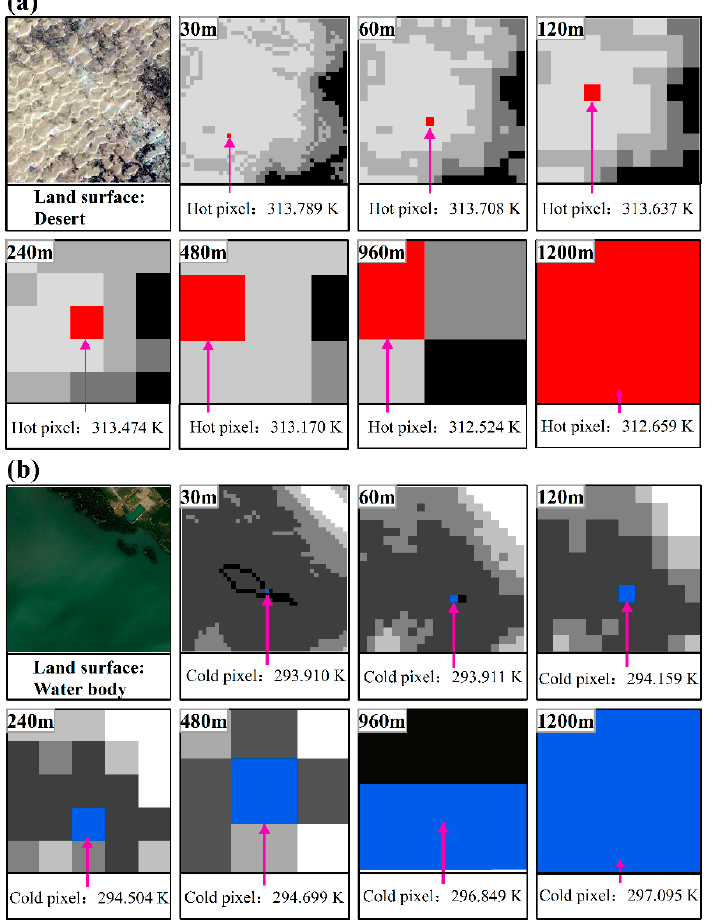
Figure 11. Locations and values of the ( a ) hot pixels and ( b ) cold pixels at different spatial resolu-